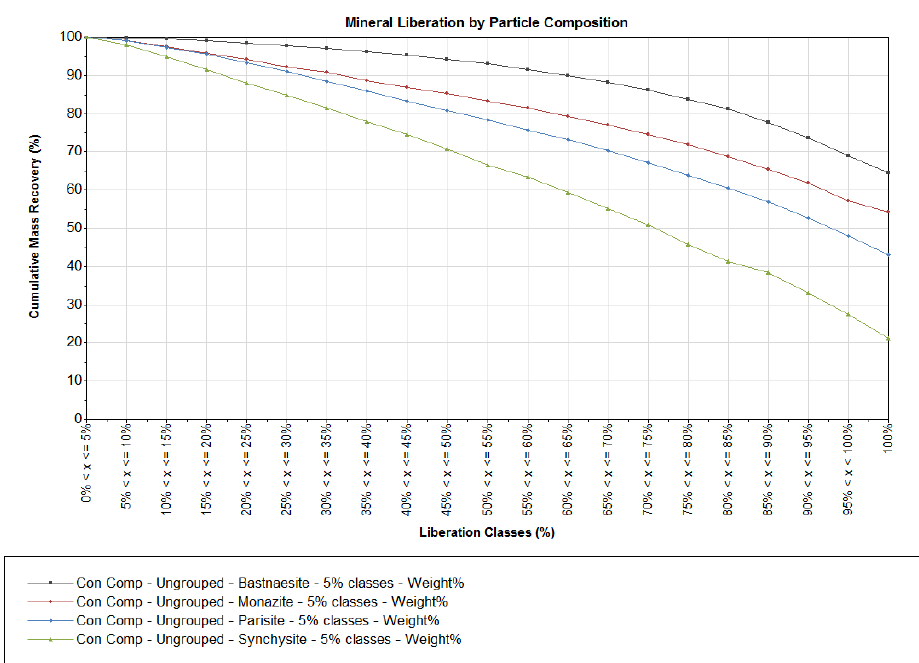
Figure 6. Mineral liberation by individual REE mineral species in MPC material MLA sample.